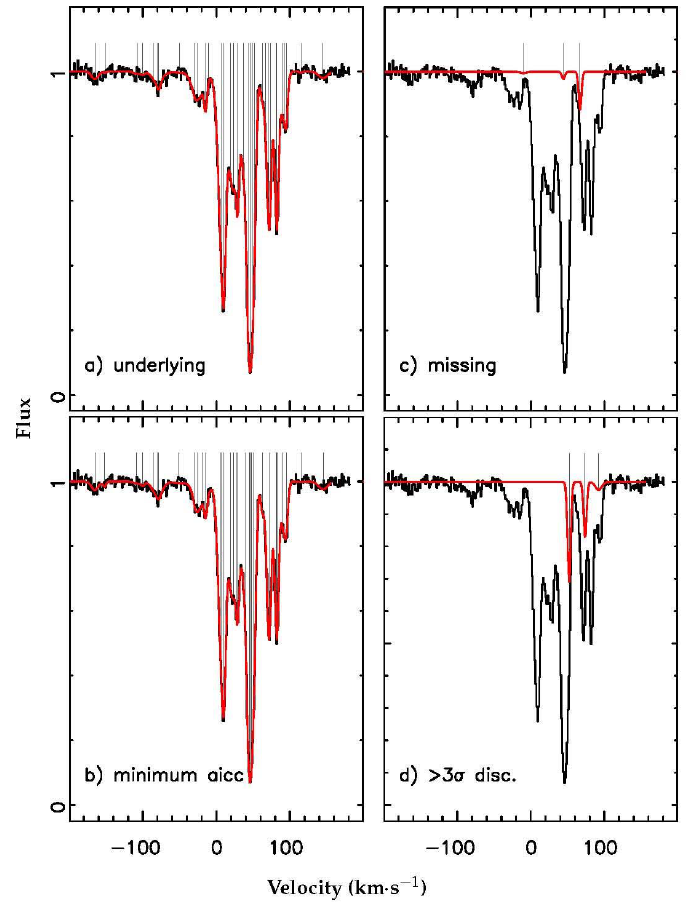
Figure 3. Comparison of the minimum- AICc model and underlying (real) model for the most complex synthetic spectrum (37 velocity components) in our sample. The synthetic spectrum (black) shown against various models (red). Panel ( a ): the underlying (real) model. Panel ( b ): the minimum- AICc model selected from the set of all models generated by GVPFIT. Panel ( c ): the three underlying velocity components not present in the minimum- AICc model. Panel ( d ): the three underlying velocity components that were inaccurately estimated by the minimum- AICc model (discrepancies of >3 σ in at least one Voigt profile parameter, using the statistical uncertainties determined from the diagonal terms of the covariance matrix at the best-fitting solution). The central position of each velocity component is indicated by a tick (gray vertical